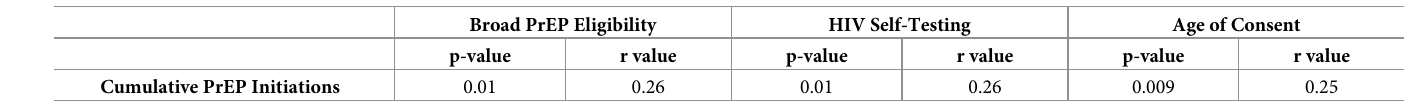
Table 2. Correlation & significance